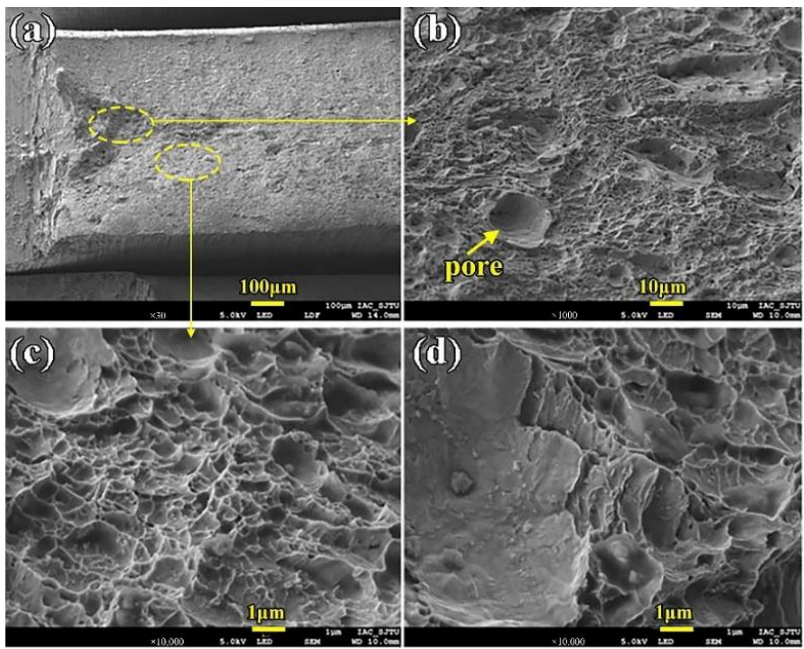
Figure 14. The WM impact fracture surface morphology ( a ) Macro-morphology ( b ) Fiber area morphology ( c ) Dimples details in fiber area ( d ) Dimples details in radiation area.